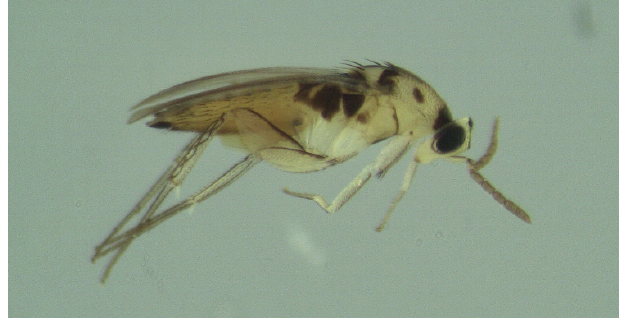
Fig 1 . Elasmus polistes emerged from the nest of Polistes